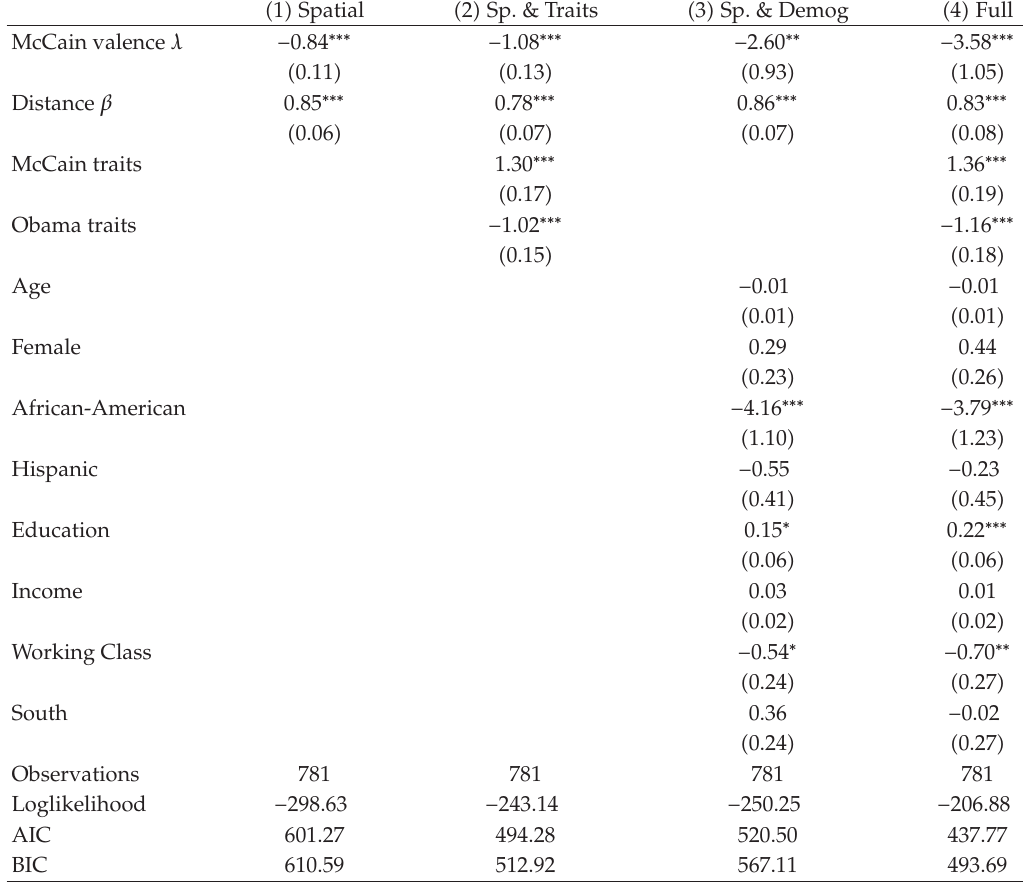
Table 8: β -spatial conditional logit models for USA (cid:2) 2008 (cid:3)